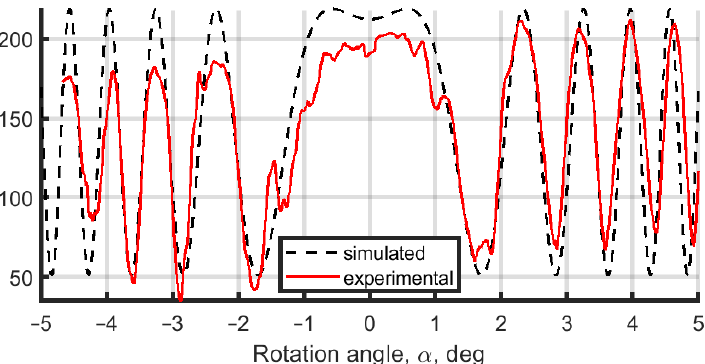
Figure 5. Hologram’s single pixel intensity dependence from rotational angle of the plane paral- lel plate.